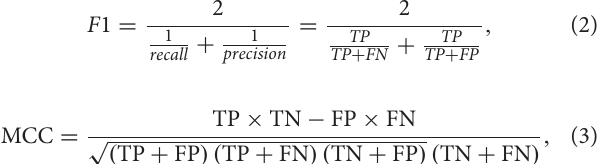
Frontiers in Pharmacology |